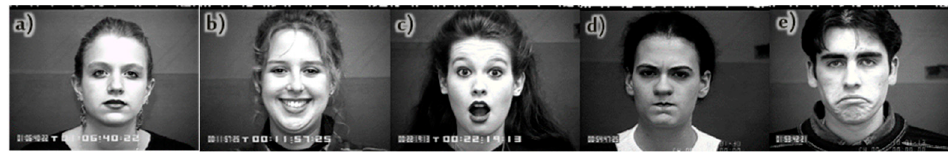
Figure 6. Cohn-Kanade plus database, ( a ) neutral, ( b ) happiness, ( c ) surprise, ( d ) anger, ( e ) sadness.